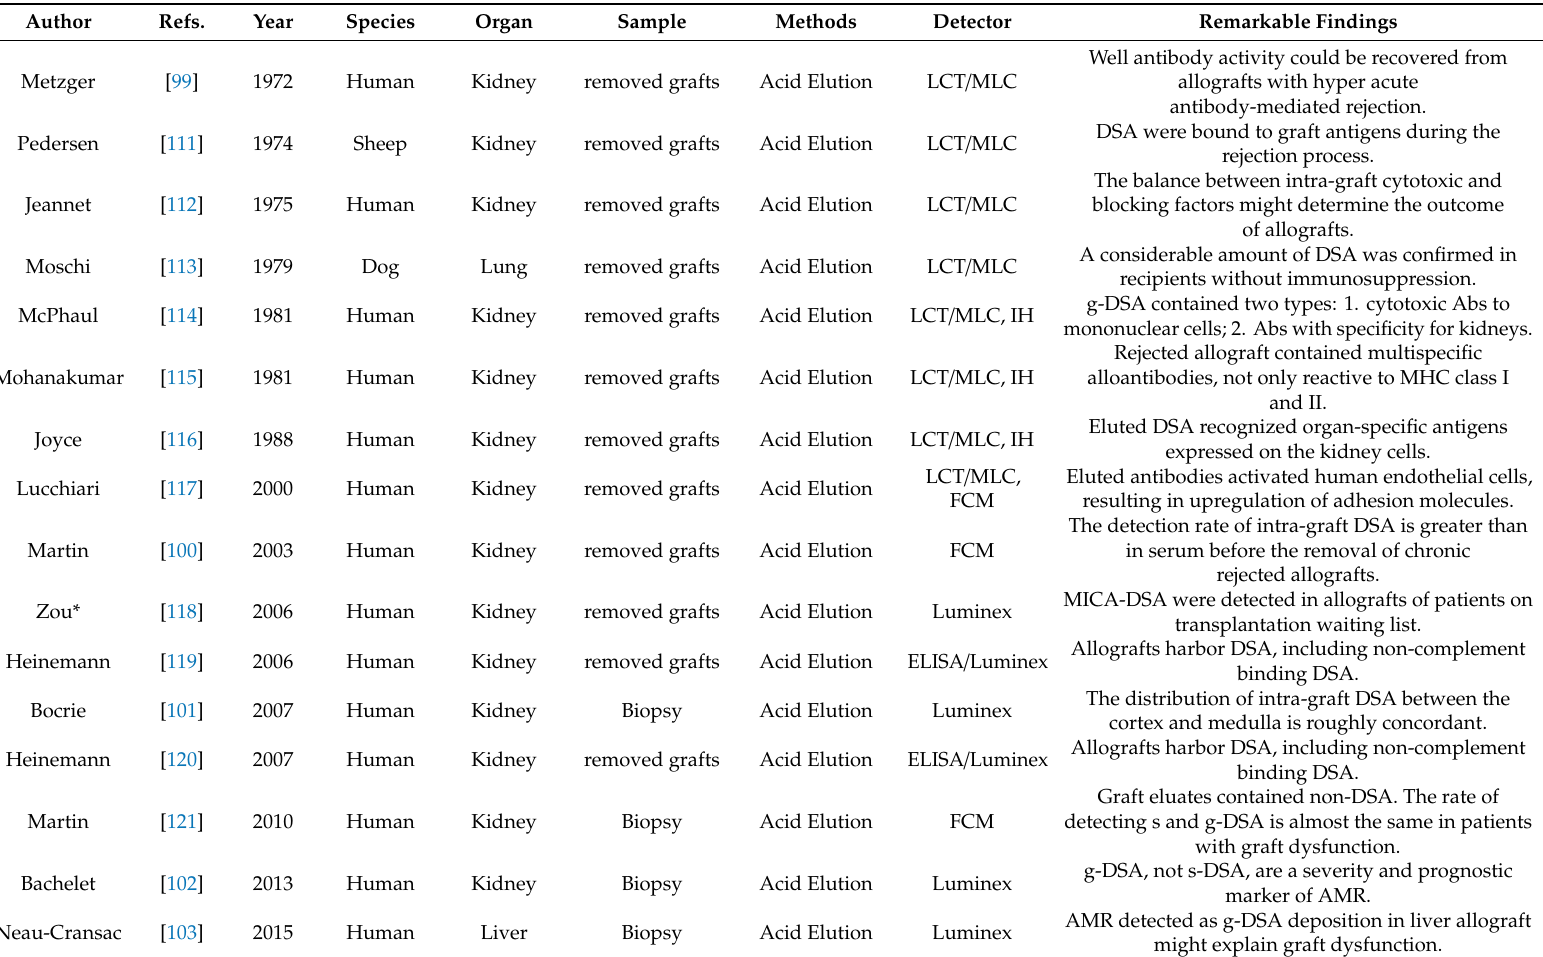
Table 1. Assessment of intra-graft donor-specific anti-MHC (HLA) antibodies